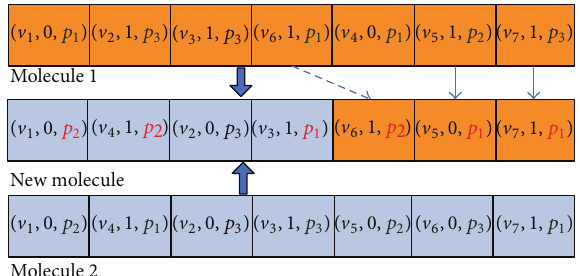
Figure 10: Illustration of molecular structure change for synthesis.